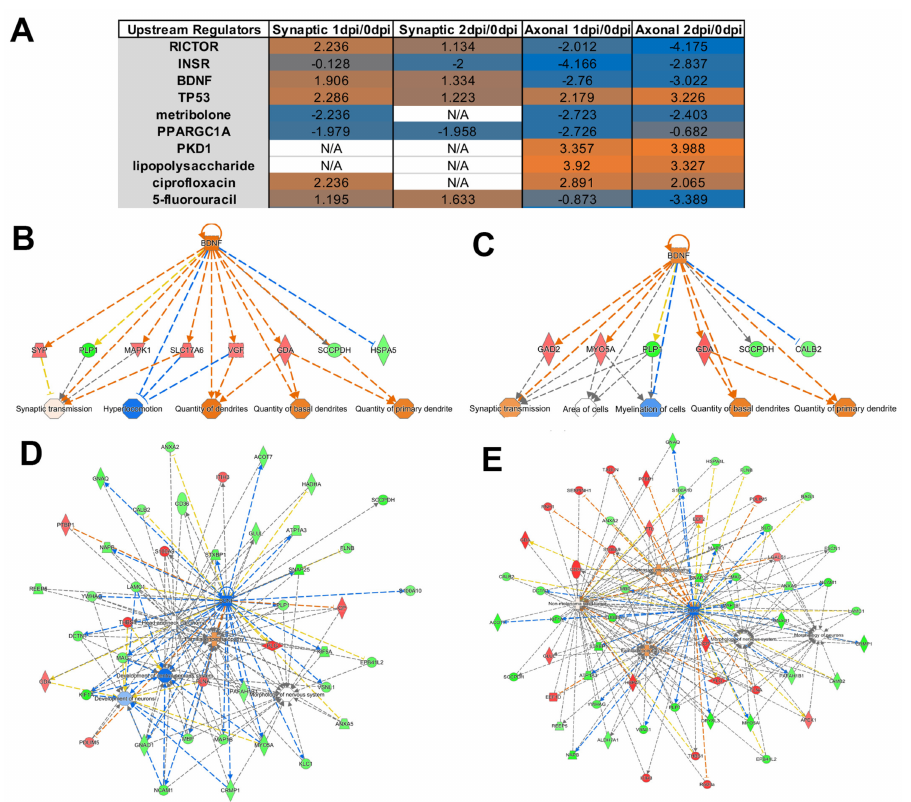
Figure A3. Overlay of expression profile trends within axonal versus synaptic compartments post- injury reveals predictive convergence upon known regulators of Wallerian degeneration. ( A ) Sum- mary table of top 10 upstream regulators mediating identified biologically relevant axonal and synaptic trends as ranked by absolute z-score. Note presence of known neuronal and non-neuronal (i.e., myelinating) regulators, including RICTOR, insulin receptor, BDNF, and PKD1. ( B ) Example extrapolation of mechanistic network mediated by predicted upstream activation or inhibition of BDNF signalling in the synapse ( B , C ) or axon ( D , E ), respectively, promoting alterations in down- stream protein expression as detected by respective proteomic study. As proof-of-principle, the top 5 biological functions per network consequential to expression alterations in constituent proteins rep- resent known phenotypic outcomes. See Figure A4 for an expression summary of constituent proteins in BDNF-regulated mechanistic networks depicted in ( B – E ) in synapse and axon over 1–2